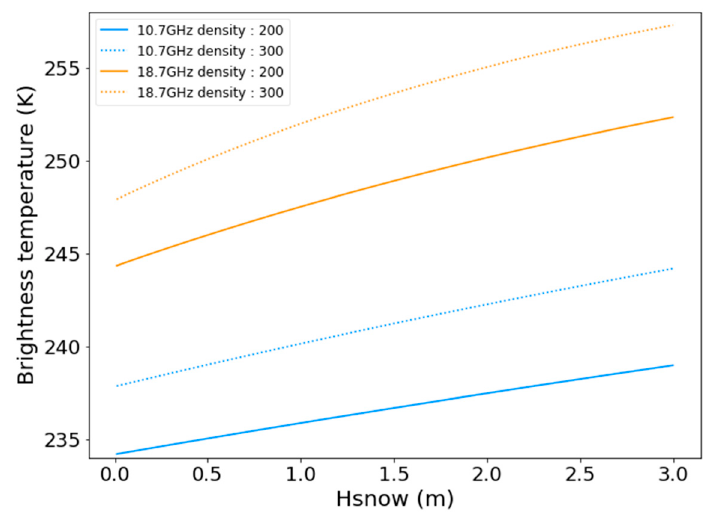
Figure 4. Sensitivity of brightness temperatures (vertical polarization) to snow depth (m) at 10.7 (blue line) and 18.7 (orange line) GHz for two densities: 200 (continuous lines) and 300 (dotted lines) Kg/m 3 , based on the model simulations from the Dense Media Radiative Transfer Model (DMRT)_Sticky-Hard-Sphere mode [55] (55 ◦ viewing angle, snow temperature = 263 K, snow grain as sticky spheres with optical radius of 0.13 mm and stickiness of 0.2, soil temperature = 273 K; and soil roughness = 0.2 cm).